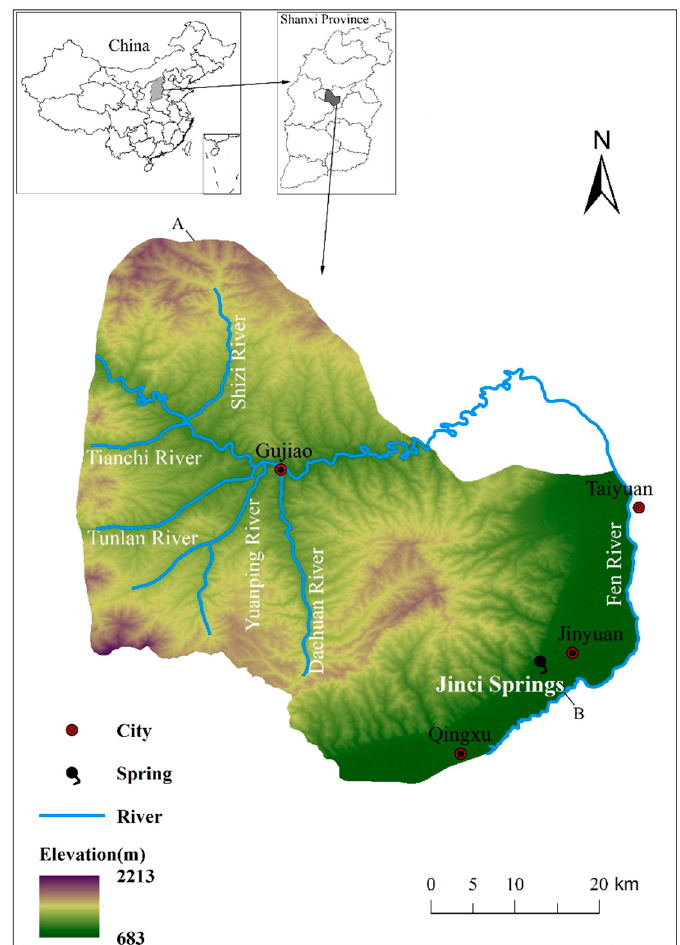
Figure 1. Location and digital elevation model (DEM) of the Jinci Springs catchment.